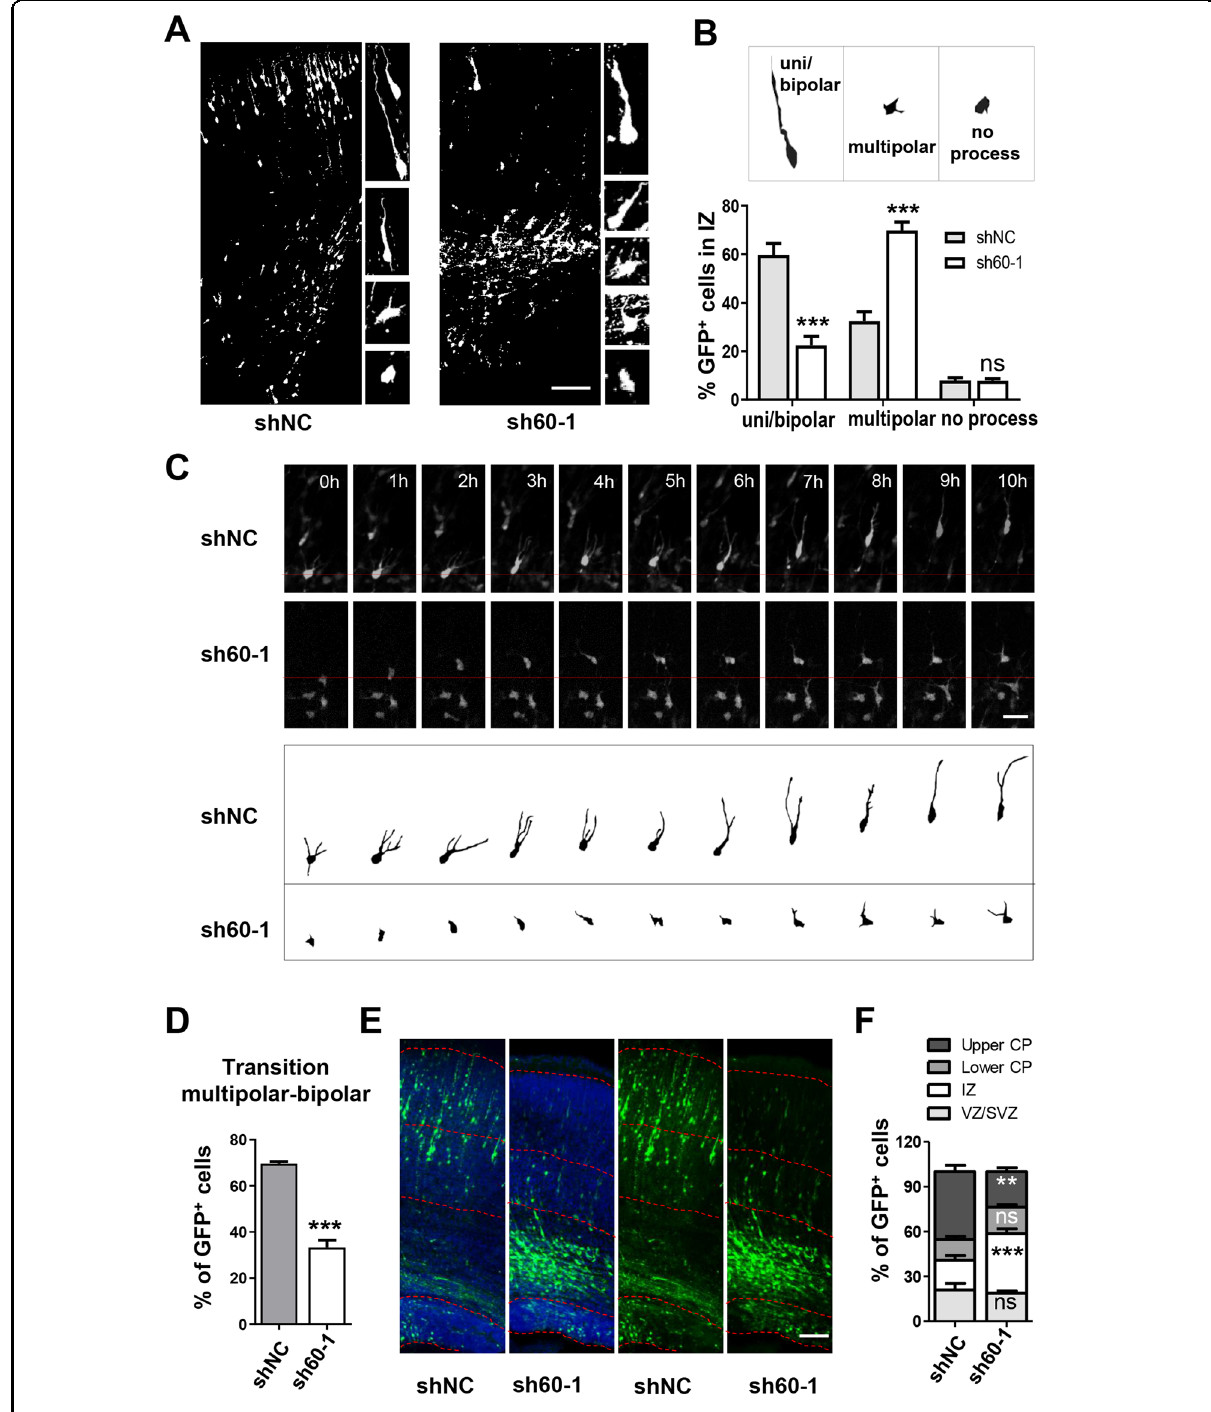
Fig. 2 Wdr60 knockdown impairs the multipolar-to-bipolar transition of migrating neurons. a , b Images of rat cortical sections electroporated in utero at E16.5 and examined at E20.5 ( a ). Scale bar, 100 µm. b Quanti fi cation of EGFP + cells exhibiting different morphology in the IZ. Upper panel: the cell morphology was delineated based on EGFP fl uorescence. n : 6 slices from 3 mice. c Representative images of live imaging. E14.5 mouse embryos were electroporated with scramble or sh60-1. Cortical slices were prepared at E16.5, and the migration of EGFP + neurons were observed for 10 h. Lower panel: neurons were delineated based on the cells labeled by red line at 0 h in the upper panel. Scale bars: 30 μ m. d Quanti fi cation of EGFP + cells that completed multipolar-to-bipolar morphology transition during the recording period. shNC n = 4, sh60-1 n = 3. e , f Images of rat cortical sections electroporated in utero at E16.5 and examined 6 days later (E22.5 or P0) ( e ). Scale bar: 100 μ m. f Quanti fi cation of the distribution of EGFP + cells. n: 6 slices from 3 mice. All data are means ± SEM, t -test. ** p < 0.01, *** p < 0.001.